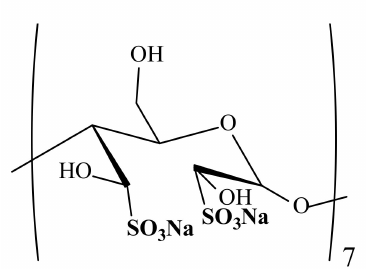
Figure 1. Chemical structure of the substance KS-6469